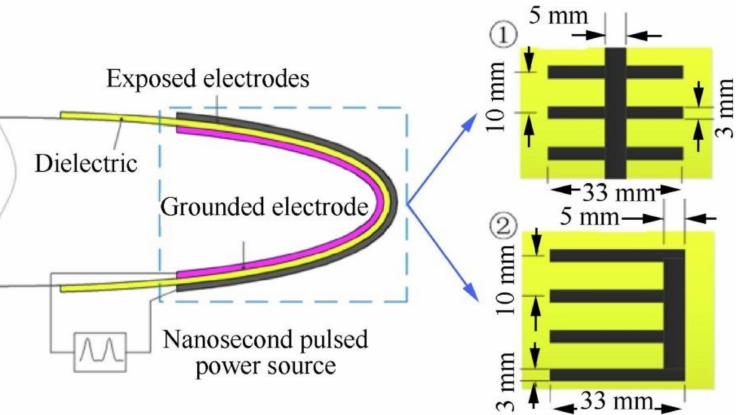
Figure 23. Two different configurations of streamwise plasma heat knife mounted at the leading edge of the airfoil from Su et al. [186] (with permission under a Creative Commons